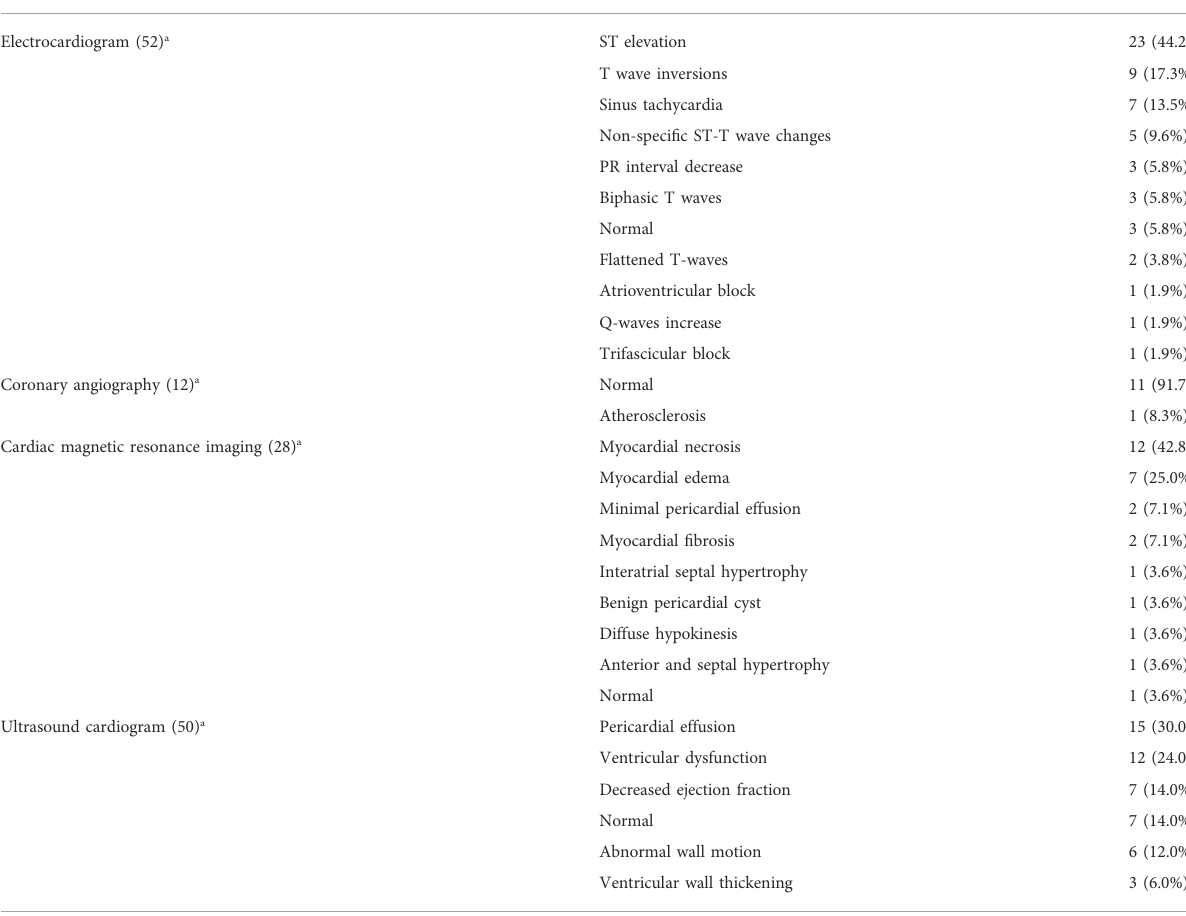
TABLE 3 Imaging examination of 52 patients reported in case